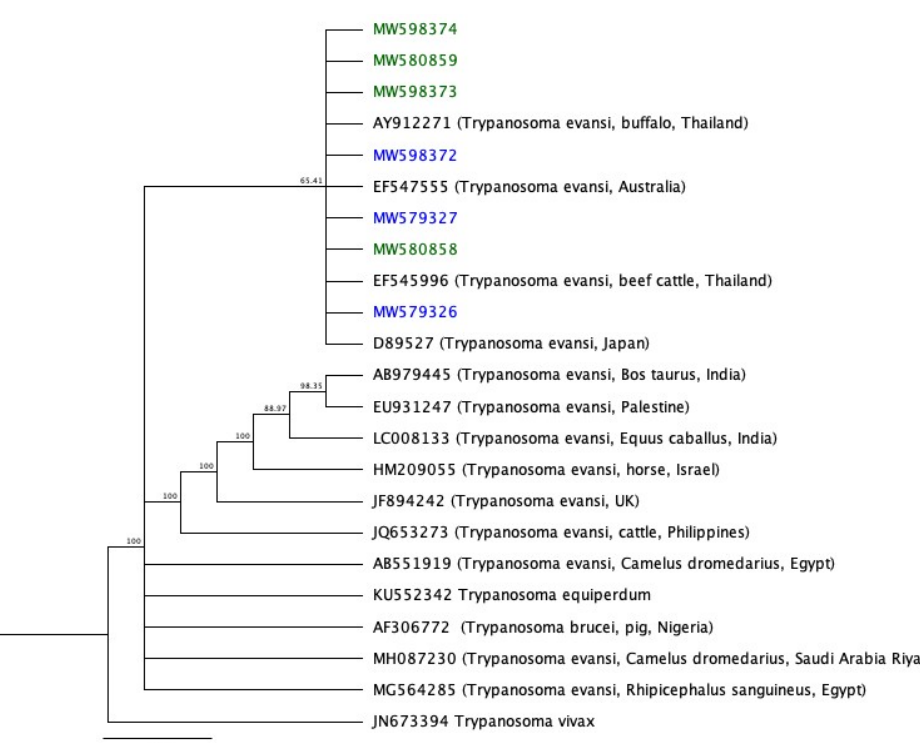
Figure 2. Genetic relationships between samples in the current study and other species. Retrieved from GenBank.